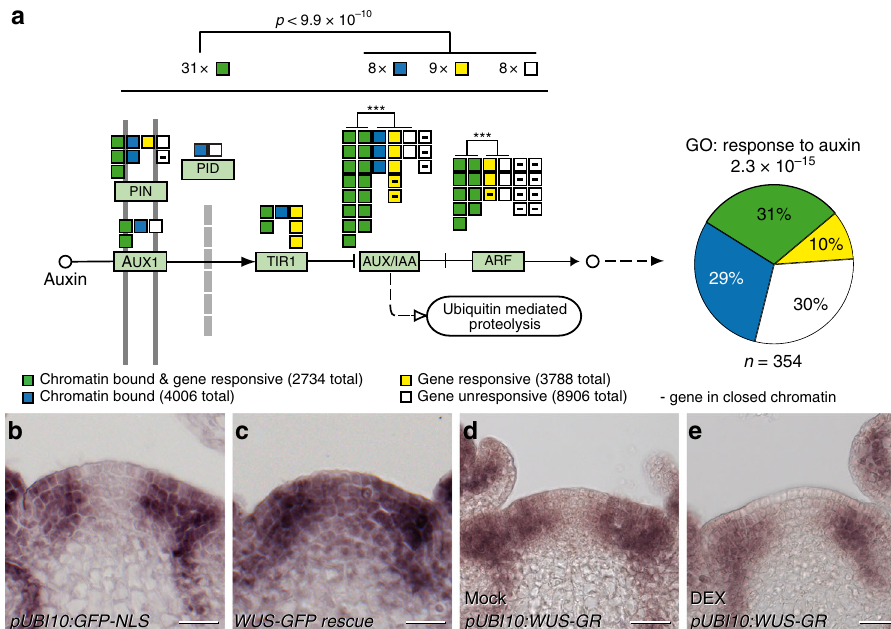
Fig. 5 Pathway level control underlies WUSCHEL mediated gating of auxin signaling. a RNA-seq and ChIP-seq data demonstrate that WUS globally affects the auxin pathway, including transport, perception, signal transduction, as well as transcriptional response. Genes involved in the auxin signaling pathway are depicted as color-coded boxes, data on WUS binding and transcriptional response are shown in Supplementary Table 2. Across the entire pathway, WUS bound and responsive genes are overrepresented ( p < 9.9 × 10 − 10 Fisher exact test for 2 × 2 matrix, bound and responsive genes (green color code) vs. all other classes, open chromatin as a background). Even within gene families, such as AUX/IAA or ARF , WUS targets are overrepresented (*** p < 10 − 4 by Fisher exact test for 2 × 2 matrix, bound and responsive genes (green color code) vs. all other classes, open chromatin as a background). Genes downstream this pathway are annotated as “ responsive to auxin ” and are also highly overrepresented among WUS targets (GO term enrichment taken from Supplementary Table 1). b , c MP RNA accumulation 24 h post anti-GFP nanobody induction in a pUBQ10:GFP-NLS control line ( b ) and the pWUS:WUS- linker-GFP wus rescue background ( c ). d , e Response of MP mRNA to ectopic activation of WUS-GR . MP RNA after 24 h of mock ( d ) or DEX